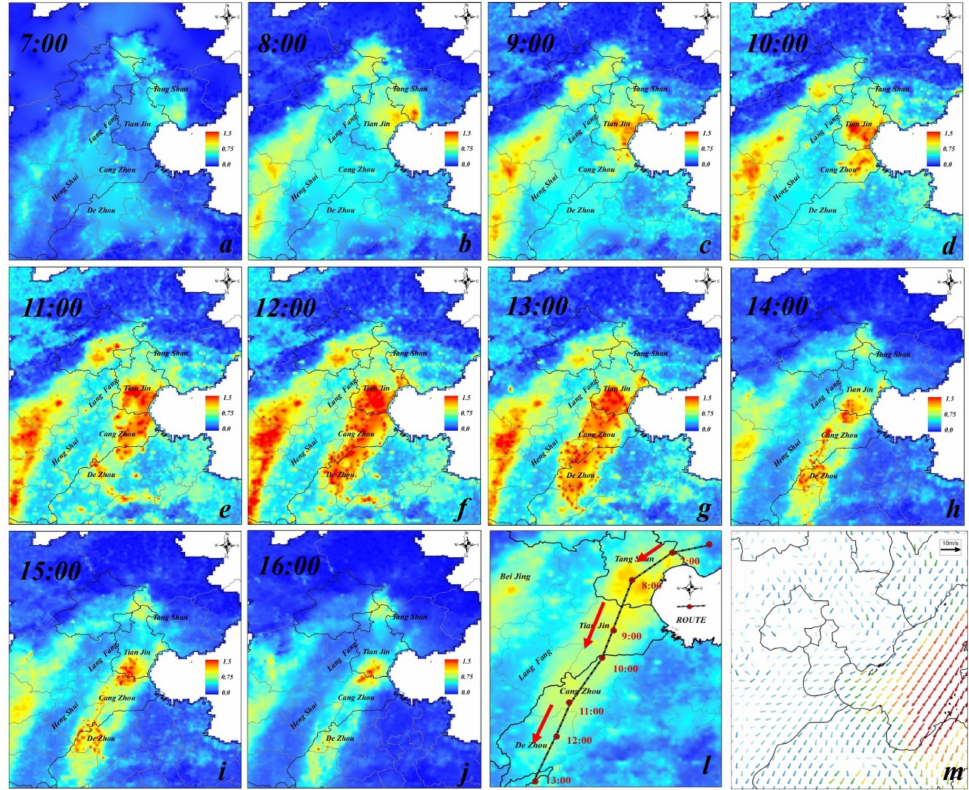
Figure 6. ( a – j ) Transmission route of the pollution process; ( l ) pollutant transport node and corresponding time advancing process; ( m ) average modelled wind speed and direction at 10 m in the E-NCP region during polluted